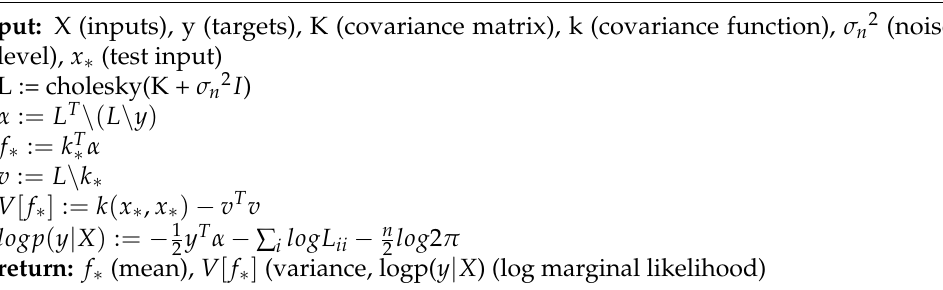
Algorithm 1 The fundamental algorithm for Gaussian Process Regression